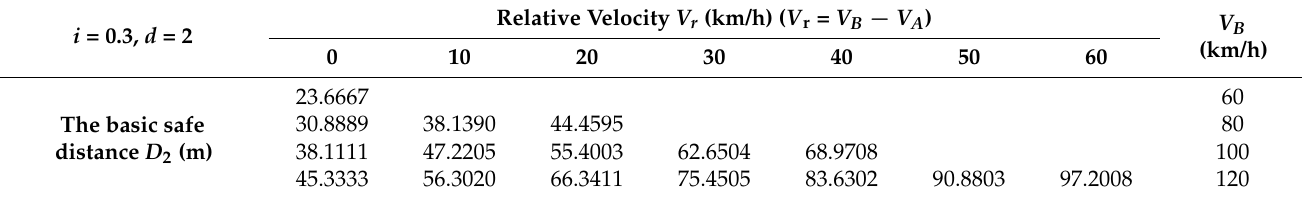
Table 6. The basic safe distance D 2 based on V B between 60 and 120 km/h when i = 0.3 and d = 2. i = 0.3, d = 2